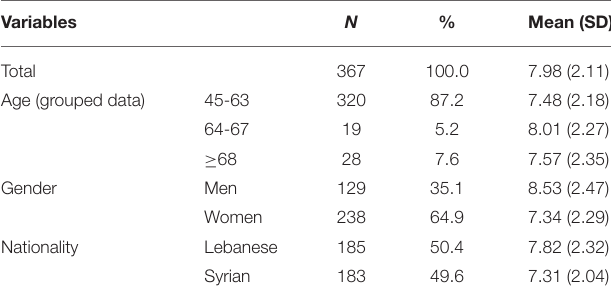
TABLE 1 | Mean adherence to mediterranean